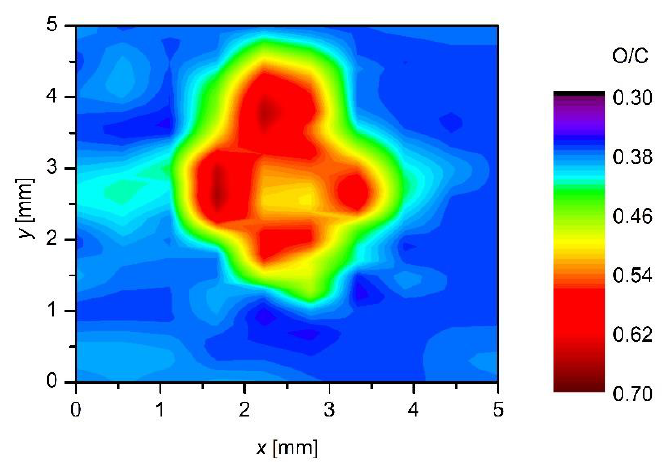
Figure 14. 2D XPS mapping of the O / C ratio of a sample treated for 3 min at a distance of 5 mm from the nozzle.